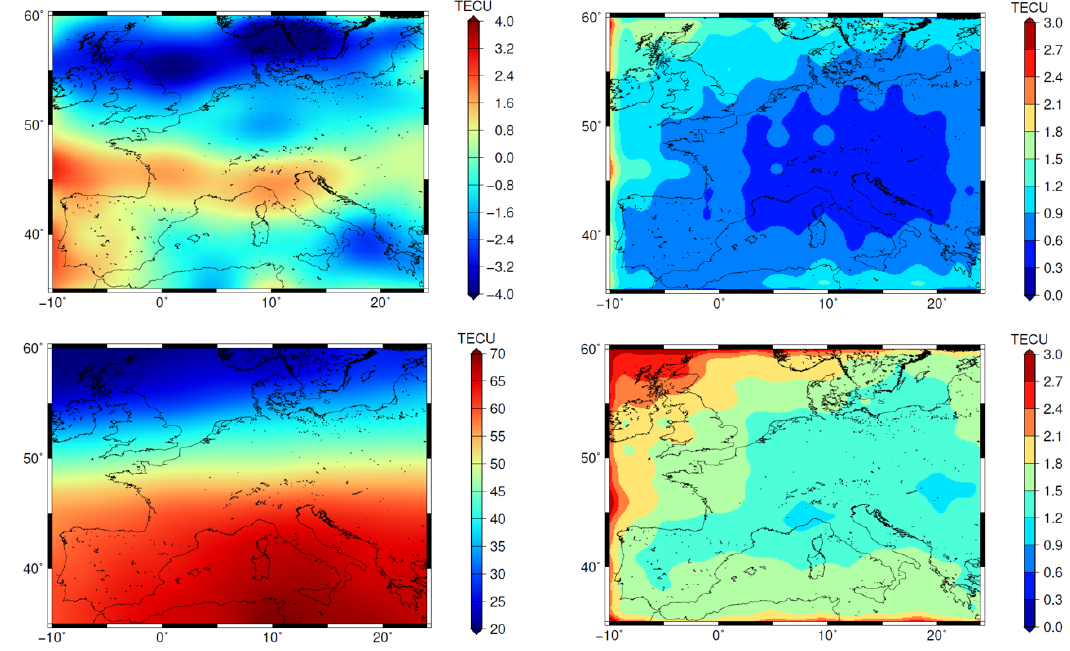
Figure 8. Estimated ∆ VTEC reg values and their standard deviations ( upper panels ) for the selected B-spline levels J 3 = 3 and J 4 = 3; estimated VTEC reg values ( bottom left ) and the corresponding standard deviation map ( bottom right ); all sets calculated for 17 March 2015 at 12:00